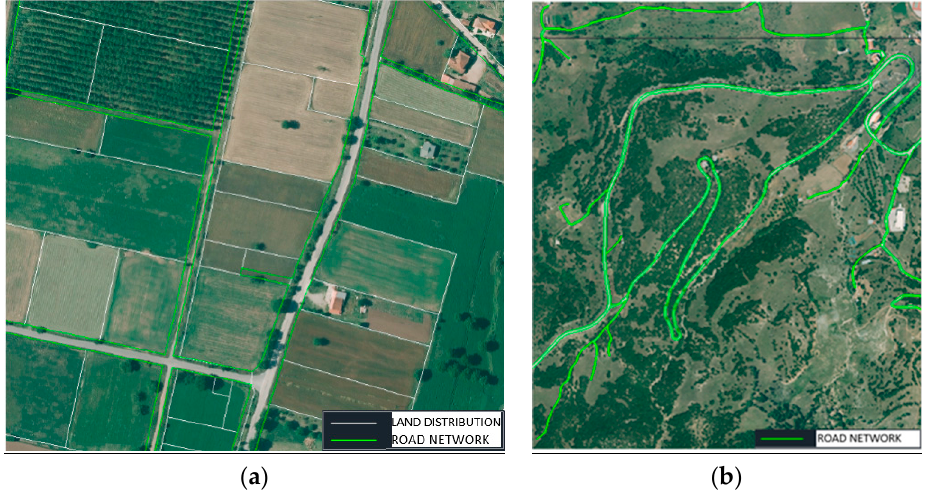
Figure 8. Digitization of the road network on the orthophoto using ( a ) existing land distribution maps and ( b ) photo-interpretation tools. Source: [35].